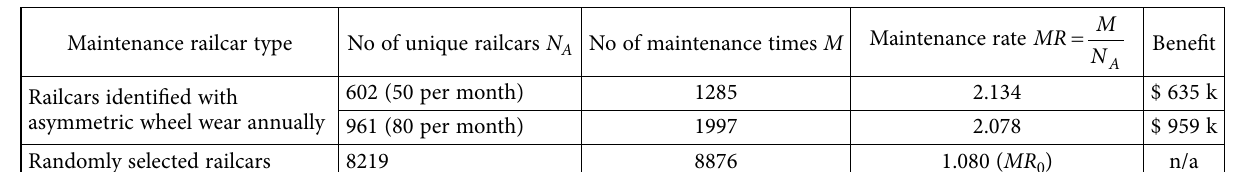
Table 5. The results of benefit analysis